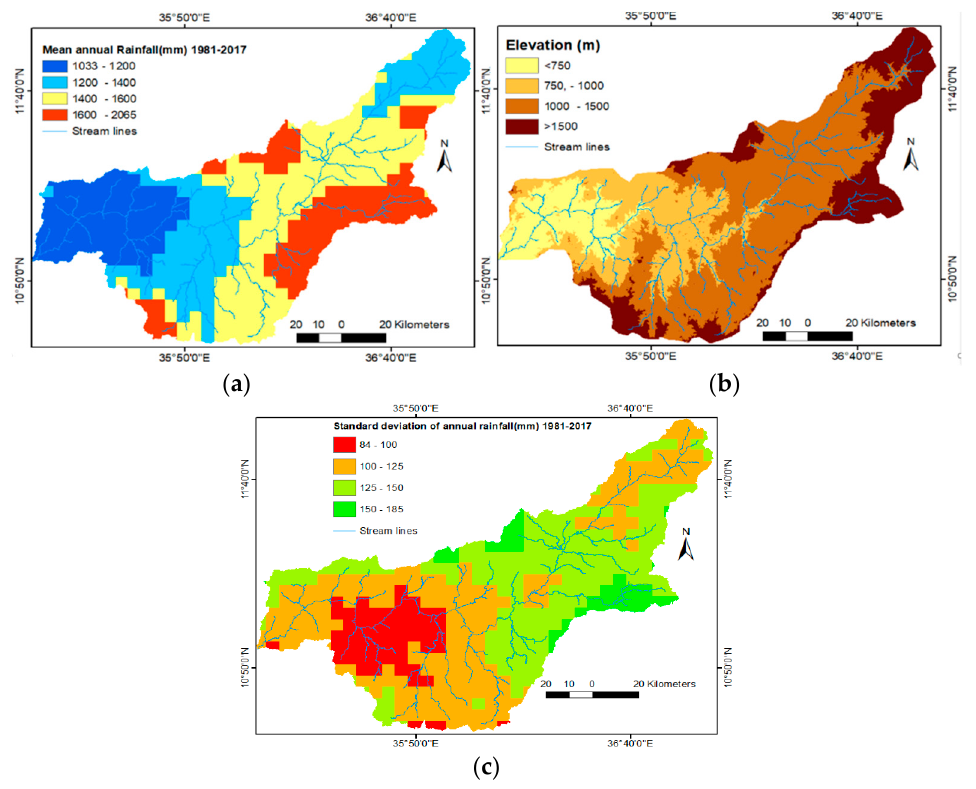
Figure 7. Rainfall regime zones from long-term mean annual rainfall; zone-1: 1033–1200 mm, zone-2: 1200–1400 mm, zone-3: 1400–1600 mm, and zone-4: 1600–2065 mm ( a ). Elevation using Shuttle Radar Topography Mission Digital Elevation Model (STRM DEM) ( b ) and standard deviation of long-term annual rainfall ( c ).